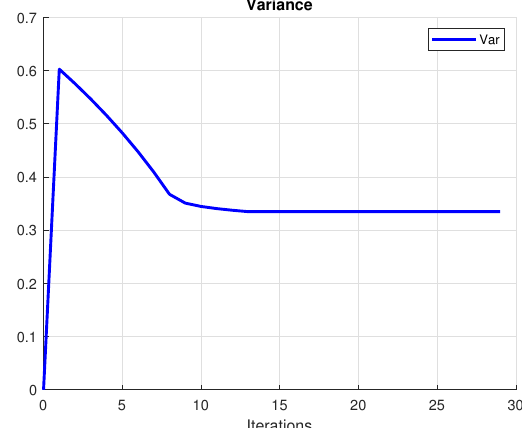
Figure 1. Utility value of the portfolio.